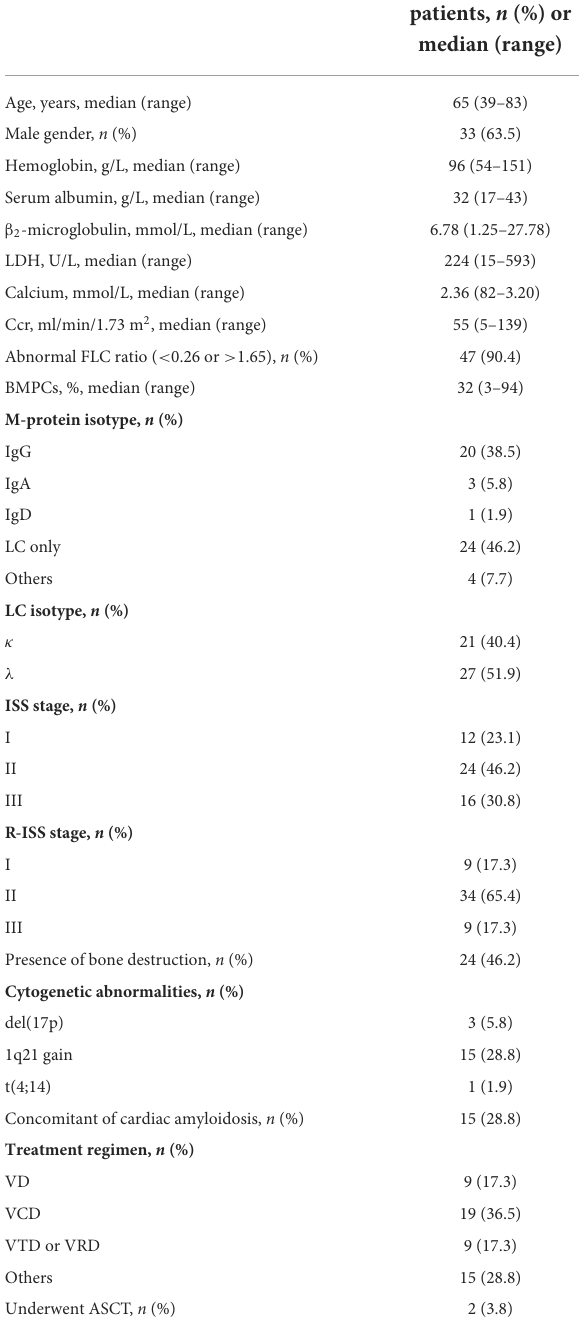
TABLE 1 Patient